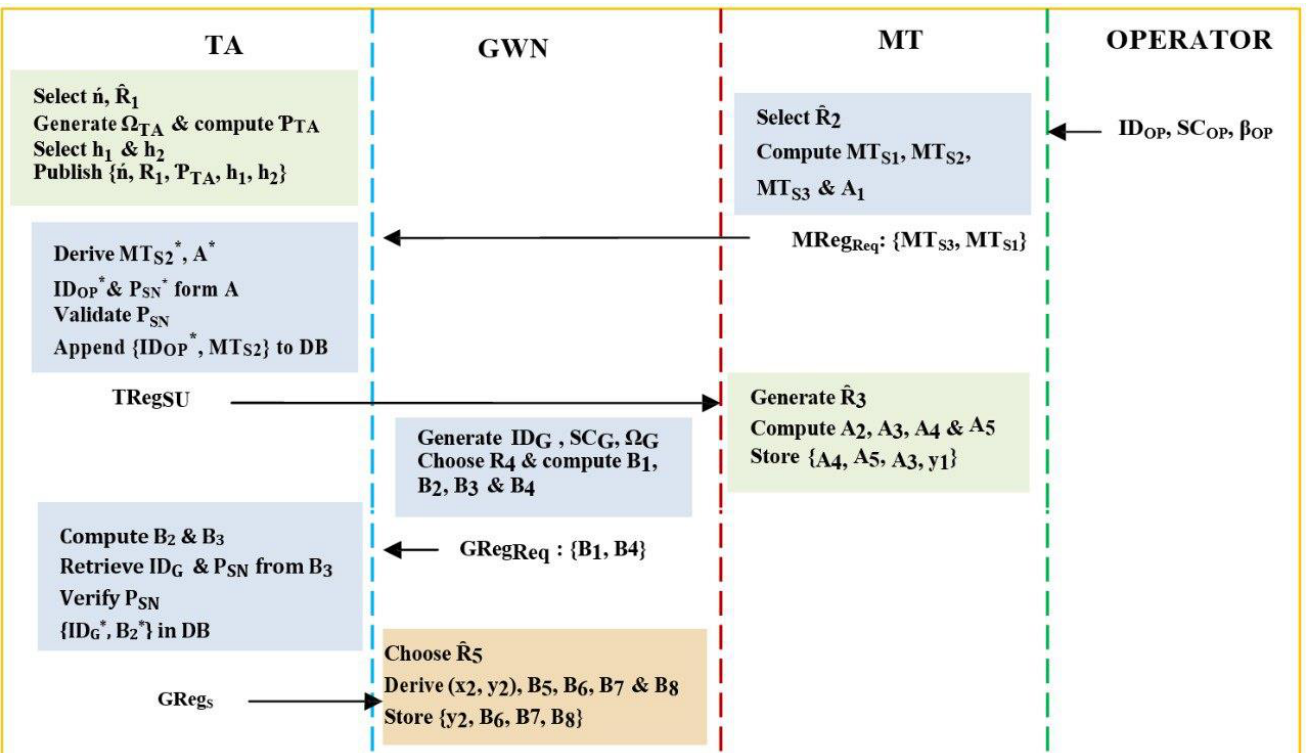
Figure 2. System initialization and registration message flows.